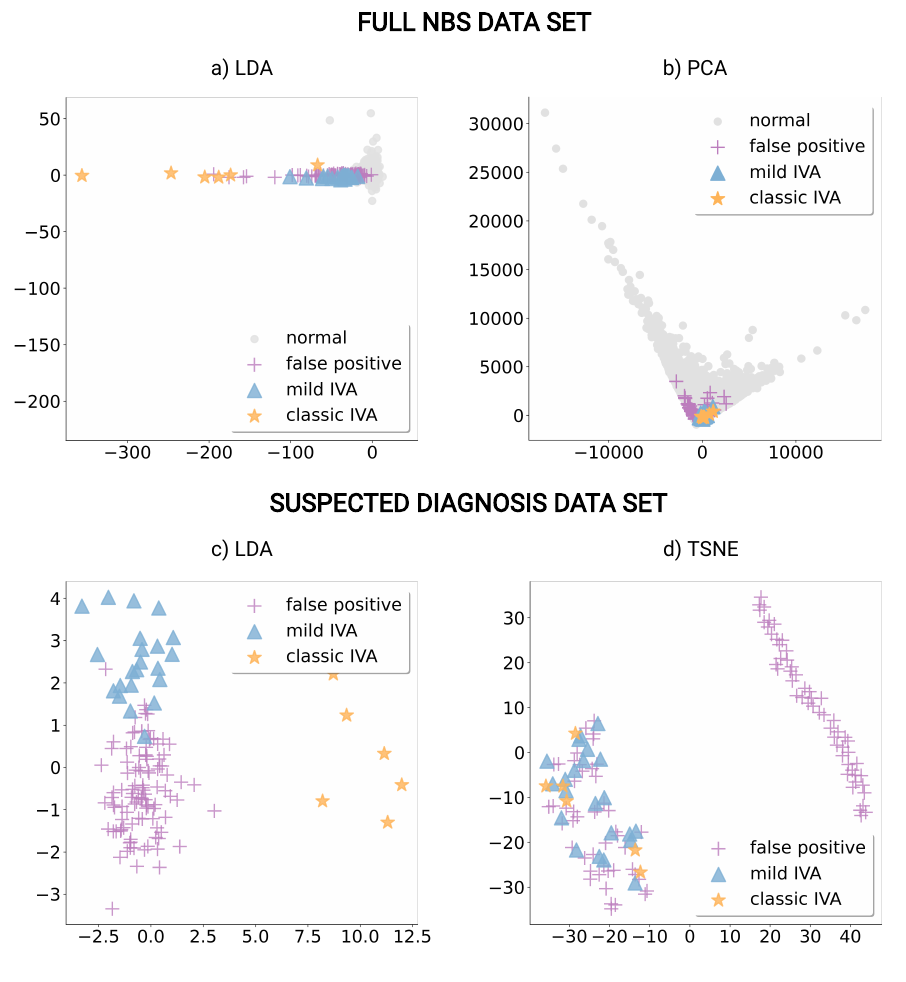
Figure 3. Dimensionality reduction plots of NBS profiles presenting normal in gray (circle) and false positive newborns in purple (cross) as well as newborns with mild IVA in blue (triangle) and with classic IVA in orange (star). Dimensions from linear discriminant analysis (LDA) are presented for the full NBS data set ( a ) and the suspected diagnosis data set ( c ). The first two principal components from principal component analysis (PCA) from the full data set ( b ) and the first two dimensions of T-distributed stochastic neighbor embedding (TSNE) created from the suspected diagnosis data set ( d ) are